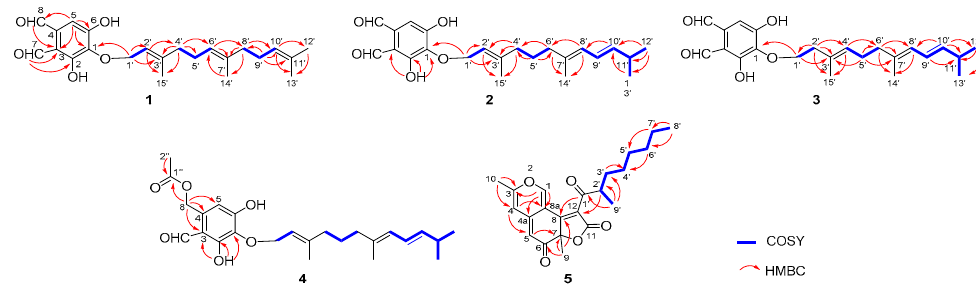
Figure 2. COSY and key HMBC correlations for compounds 1 – 5 .